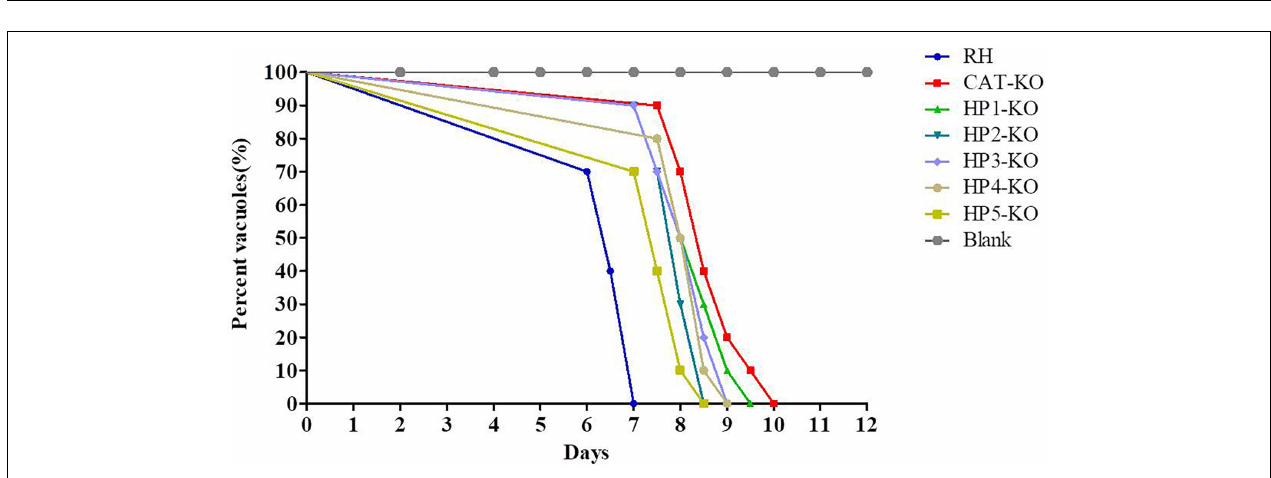
FIGURE 6 | Plaque assays. Vero cells were infected with 500 tachyzoites of each strain and cultured for 7 days. In addition, treated groups were added to H 2 O 2 -containing medium at 12 h after infection, which was replaced with a normal medium at 48 h after infection. After 7 days, plaques were stained with crystal violet and photographed. (A) Representative images (magnification: × 100). (B) Plaques formed under normal culture conditions. (C) Plaques formed under H 2 O 2 culture conditions. Data for the mutants were compared to the wild-type RH strain.